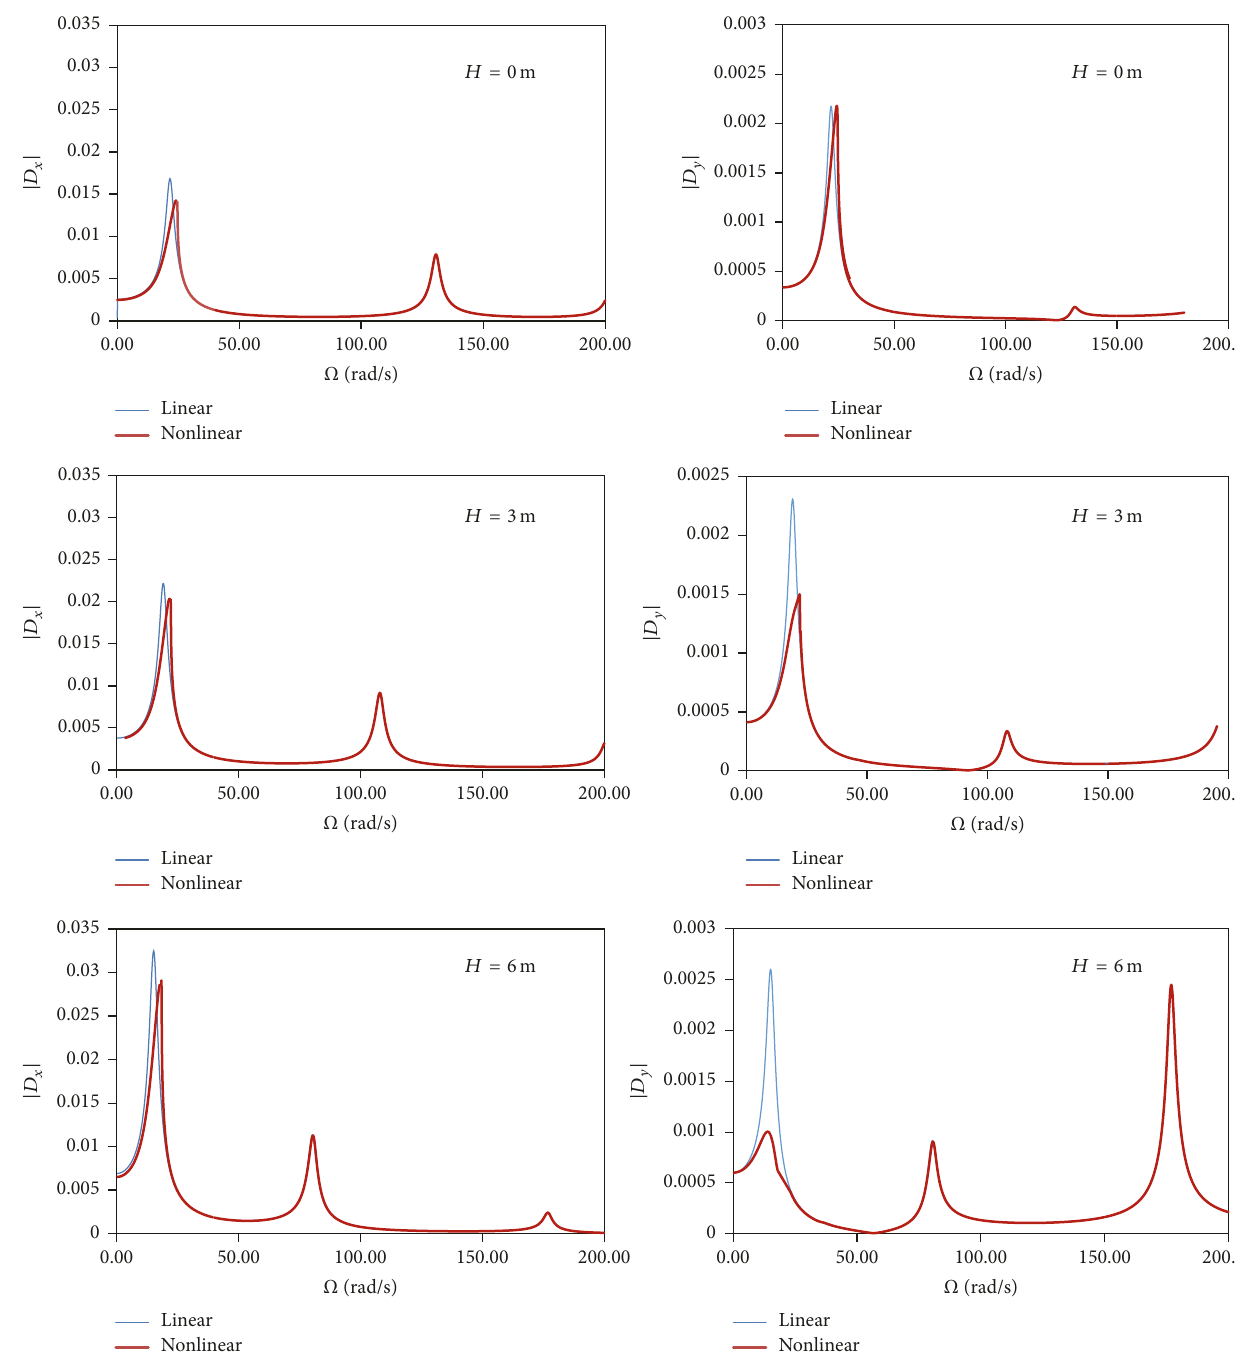
Figure 6: Variation of the norm of the horizontal and vertical vibration amplitudes at the roof top as a function of the excitation frequency for a horizontal base excitation and three values of the roof height 𝐻 . 𝐴 𝑥 = 0.96𝑔 .